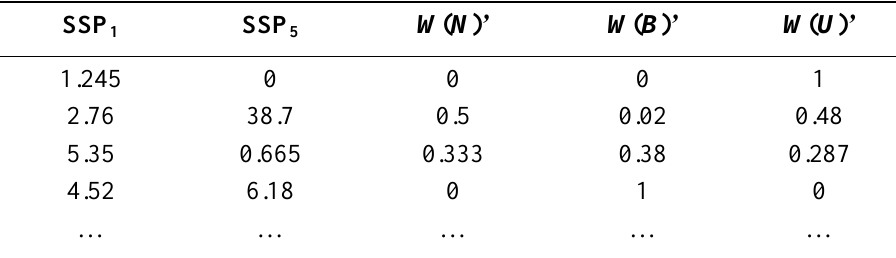
Table 6. Training data for first step of sequential diagnosis.